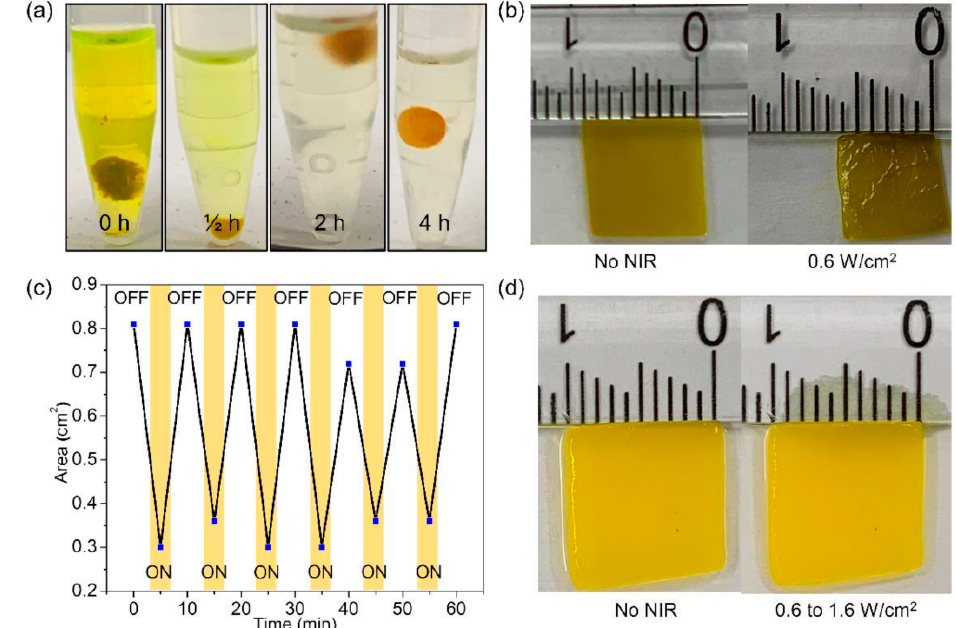
Figure 8. ( a ) Heat treatment of nanofiber under 160 °C. ( b ) Digital images of the area changes of the whole nanofiber containing gold nanorods (GNRs) upon irradiation of NIR light. ( c ) Change in area of the whole nanofiber containing GNRs as a function of cycles of temperature alternation upon the NIR irradiation. ( d ) Digital images of the area of the whole nanofiber without GNRs in the presence and absence of NIR light irradiation. Reproduced from Ref. [188].